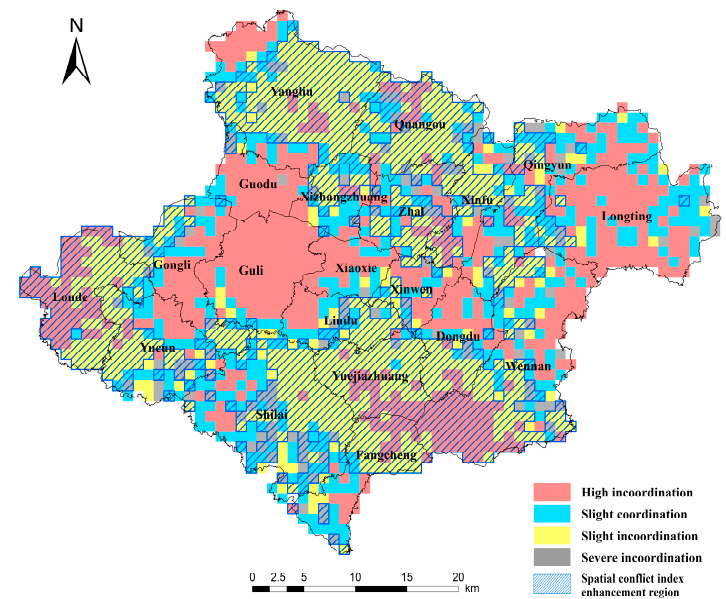
Figure 7. Spatial layout of the degree of coupling